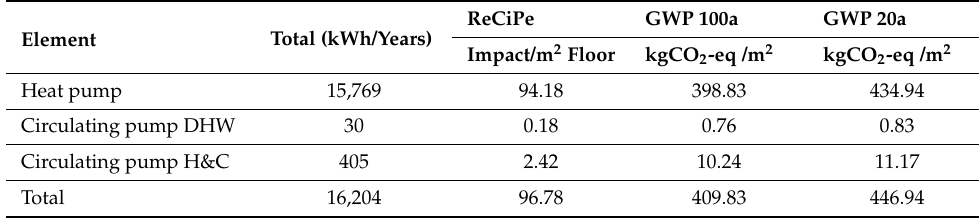
Table 9. LCIA of the reference system during the operational stage for a 30-year lifespan.